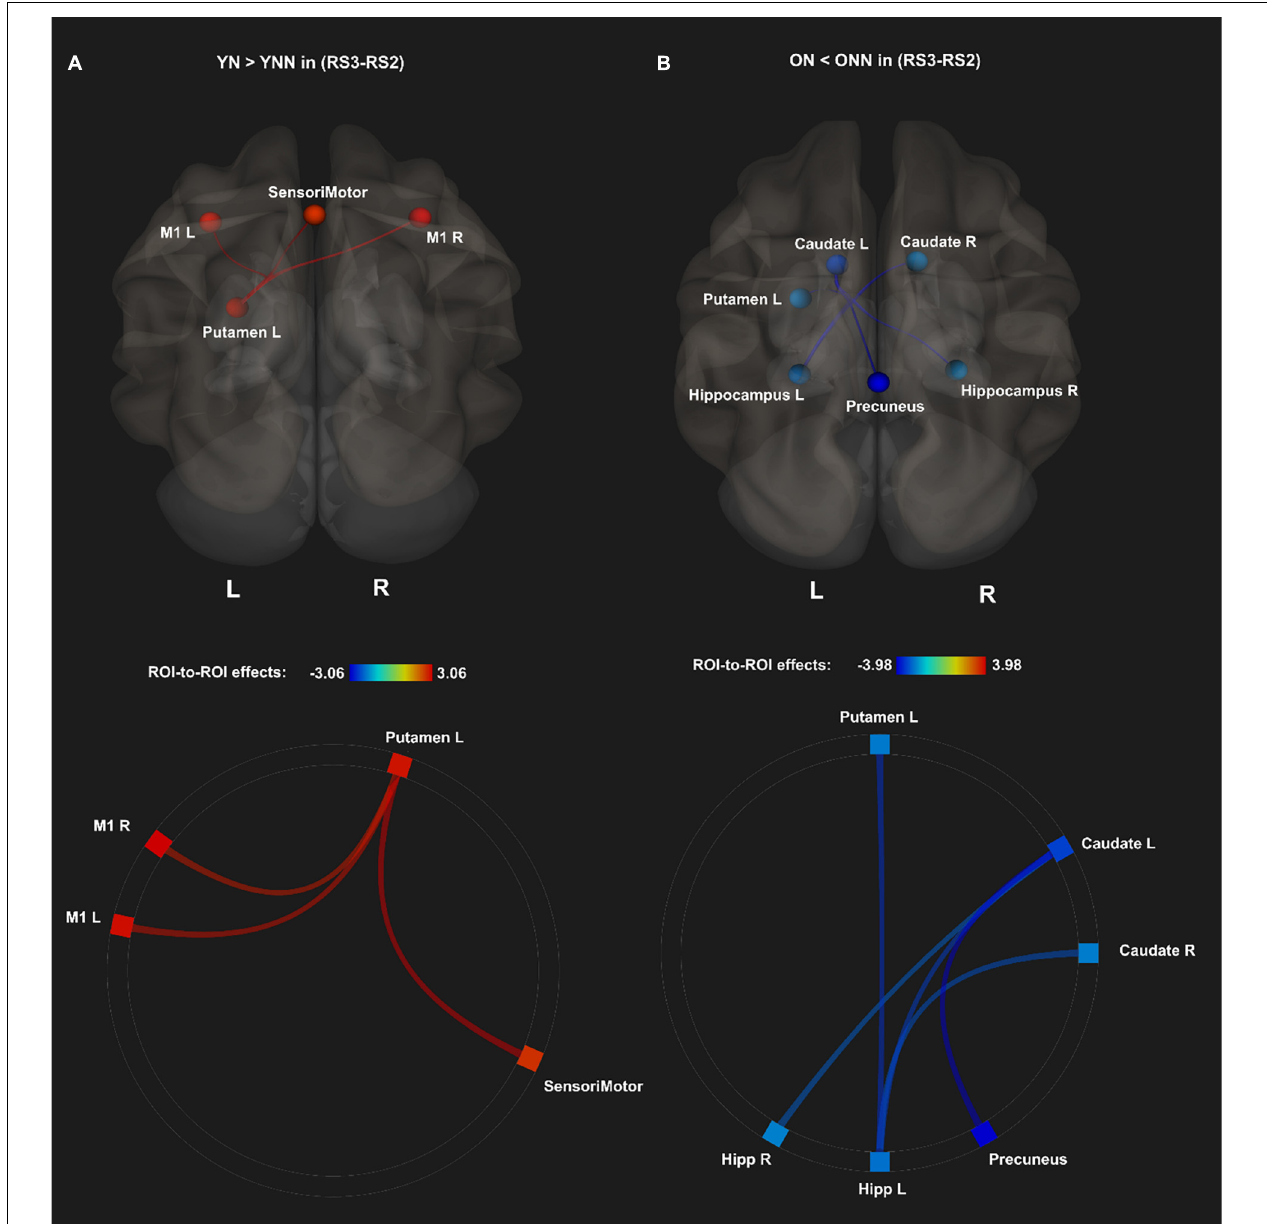
FIGURE 5 | Post hoc analyses of ROI-to-ROI effects of sleep on MSL-related FC from post-MSL training to post-consolidation interval (RS3–RS2). (A) Positive FC changes (RS3–RS2) (red) for the YN as compared to the YNN, and (B) negative FC changes (RS3–RS2) (blue) for the ON as compared to the ONN. Thresholded at p FDR < 0.05. YN, Young Nap; YNN, Young No Nap; ON, Older Nap; ONN, Older No Nap.